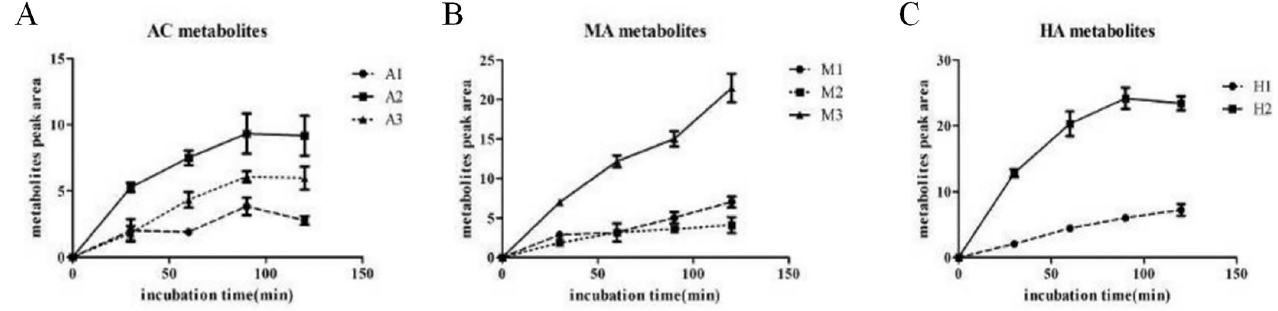
Fig 2. Time-peak area graph of the metabolites of AC, MA and HA in RLMs. 1 mg / ml microsome 100 μ L, PBS 75 μ L and aconitine alkaloids 5 μ L (1 mmol / L) were added in turn, AC and HA were incubated for 90 min, MA were incubated for 120 min for HPLC respectively. (A) The metabolites of AC increased with the increase of incubation time after 30 min, 60 min and 90 min. At 120 min, the production of metabolites basically reached the plateau stage, the optimal incubation time was 90 min. (B) The amount of metabolites of MA increased linearly in the incubation of 30–120 min. (C) The amount of metabolites of HA increased linearly in the incubation of 30–90 min, at 120 min, the production of metabolites reached the plateau stage.